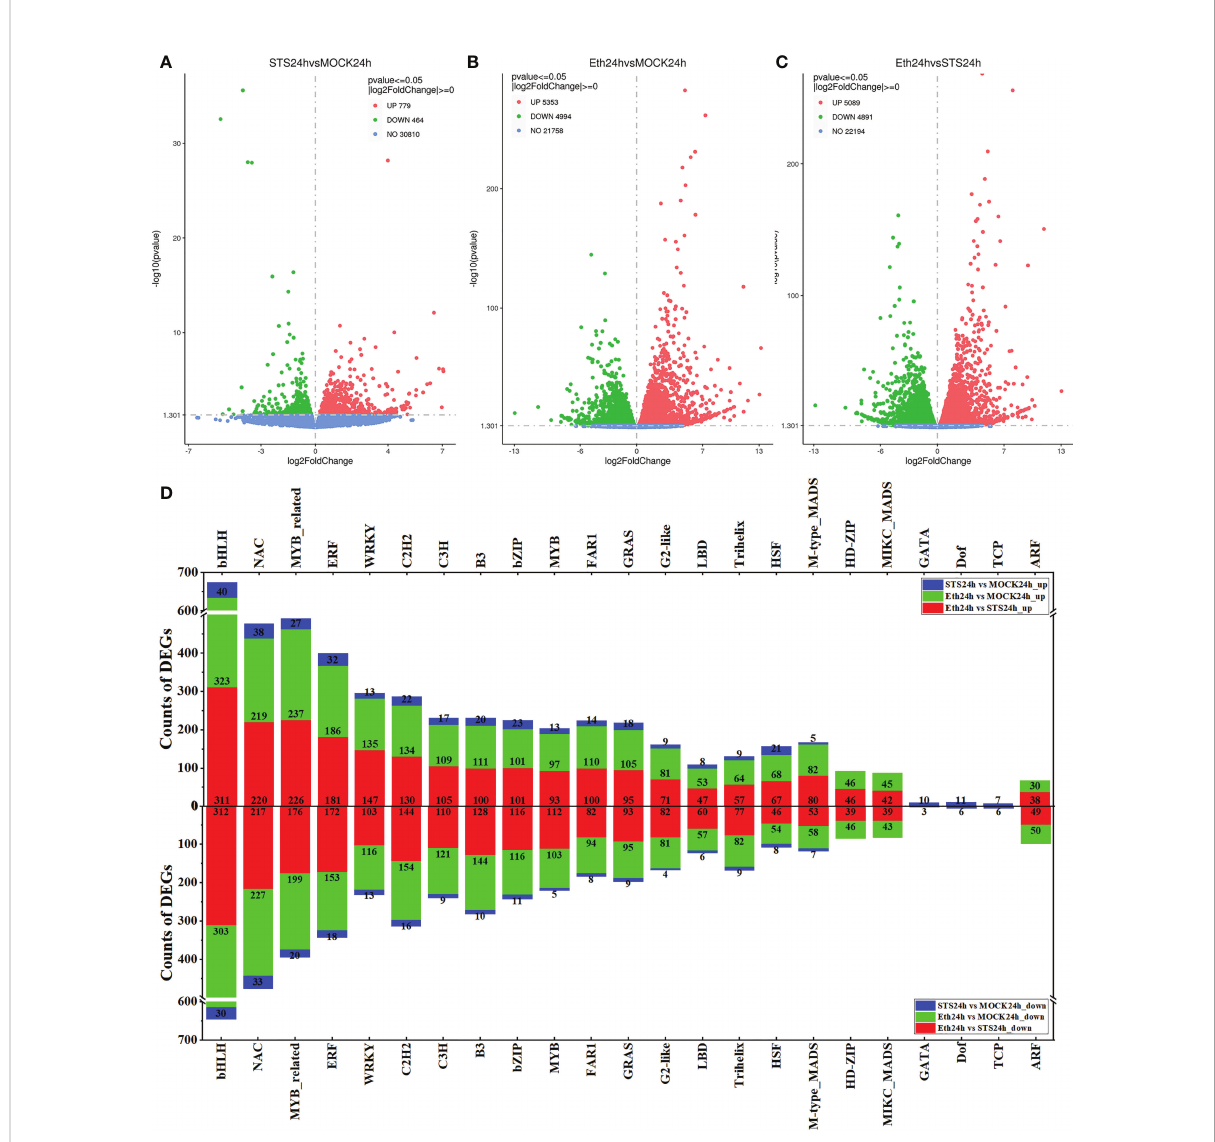
FIGURE 3 Volcano plots of DEGs and classi fi cation statistics of transcription factors. (A – C) Volcano plots. Red represented up-regulated, green represented down-regulated. (D) Classi fi cation statistics in the top 20 families of transcription